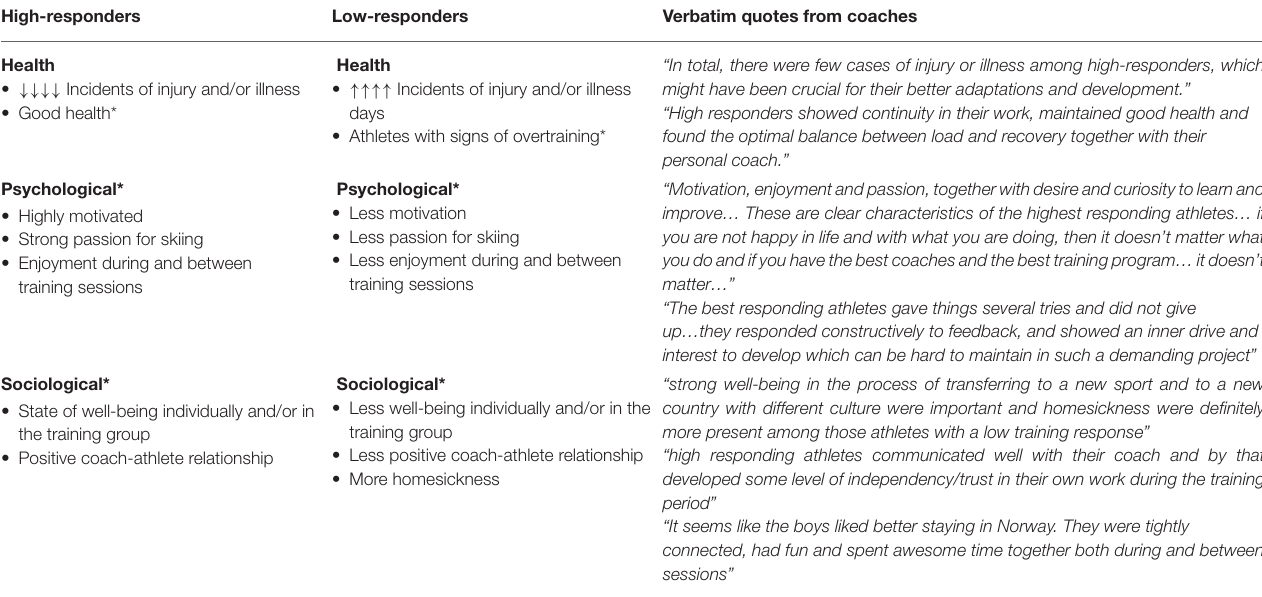
TABLE 4 | Multidisciplinary overview of health, psychological and sociological related factors differentiating high- from low-responders following 6-months of XC ski-specific training in a group of endurance transfer athletes including direct verbatim quotes from the athlete’s personal coaches.